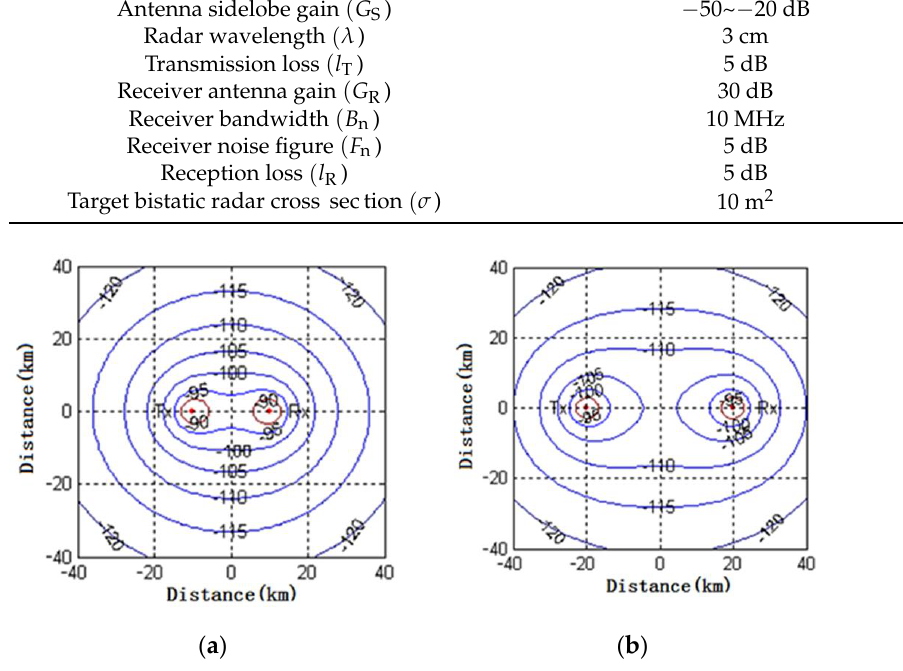
Figure 3. Contour of the target echo power: ( a ) L =20 km; ( b ) L = 40 km.